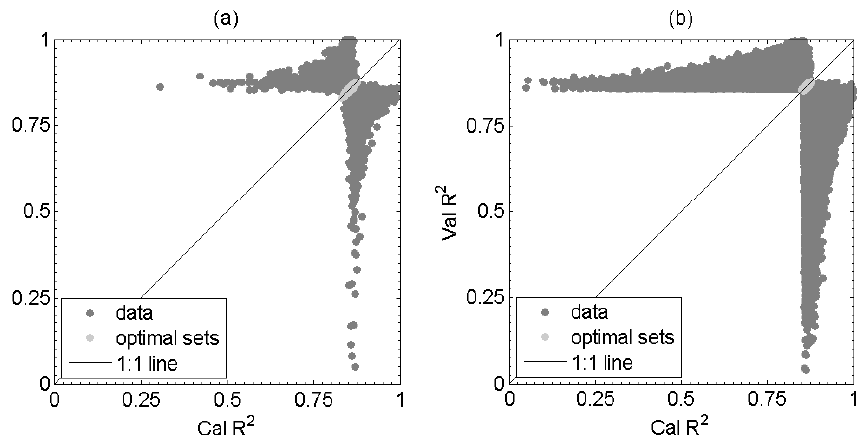
Fig. 1. Determination coefficient, R 2 , between measured and observed values of (a) soil moisture and (b) chl a absorption coefficient. The solid line is the 1 : 1 reference line. Light-grey coloured points represent the optimal Cal/Val pairs.